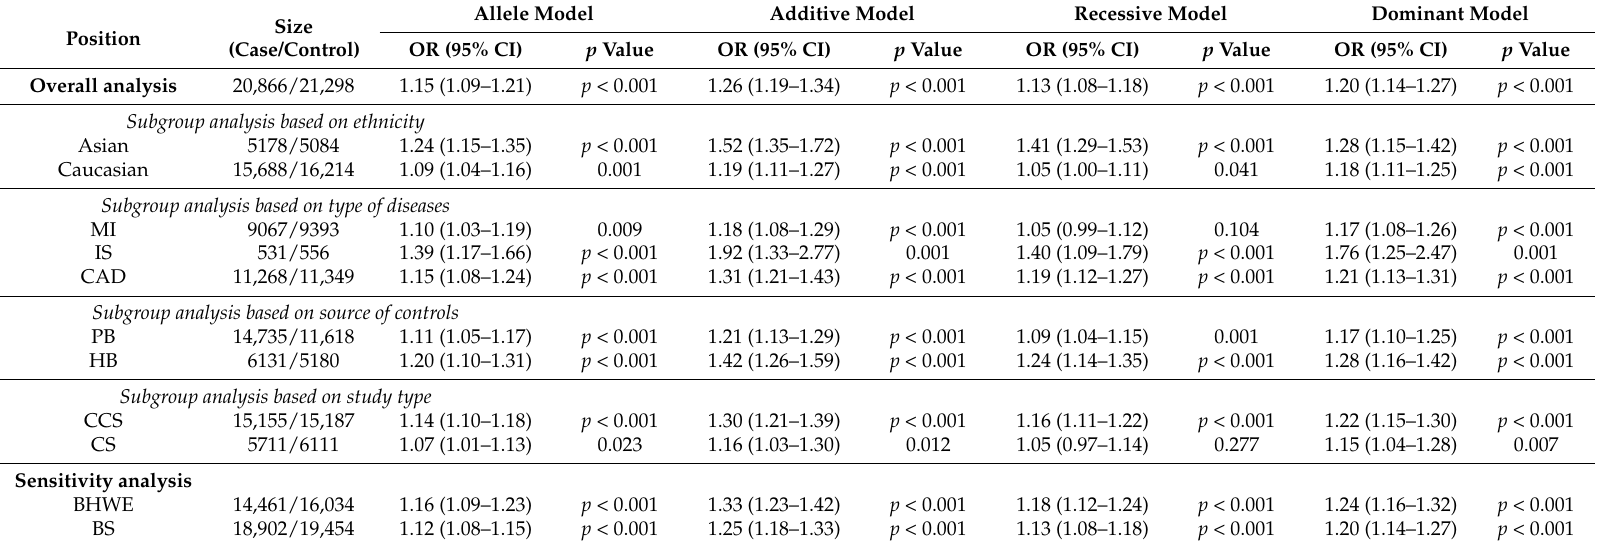
Table 3. Metal-analysis of CETP TaqIB polymorphism and risk of atherosclerosis in each